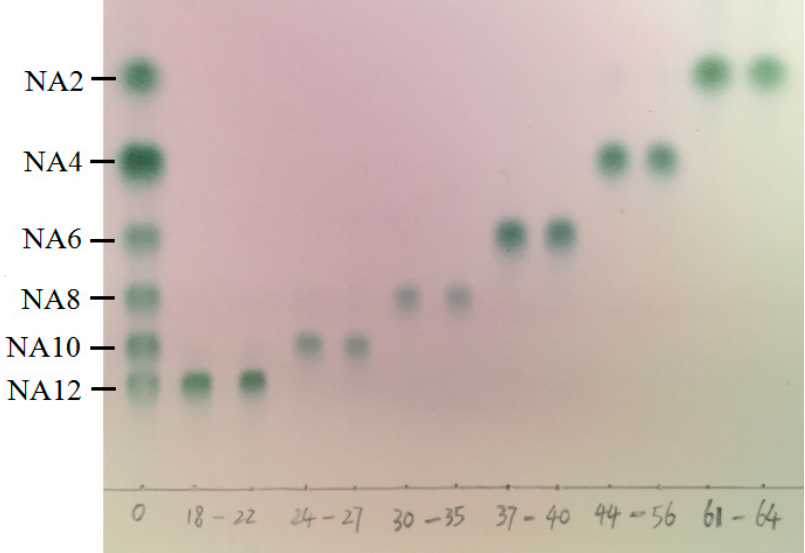
Figure 4. TLC analysis of purified NAOS. The ladder of NAOS with different DP (2-12); S: NAOS standards; Fractions 18 – 22: NA12, Fractions 24 – 27: NA10, Fractions 30 – 35: NA8, Fractions 37 – 40: NA6, Fractions 44 – 56: NA4, Fractions 61 – 64: NA2.